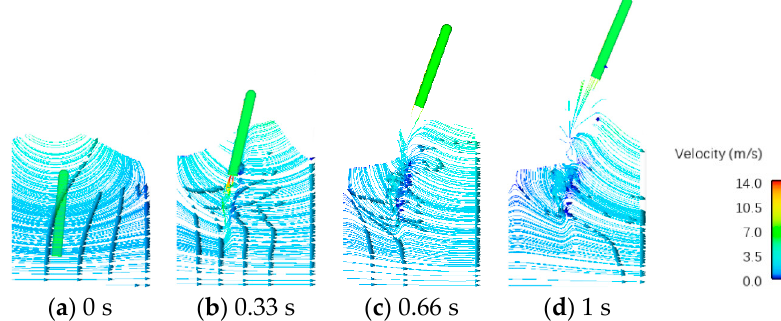
Figure 20. Streamline diagram of vehicles flying out of water in case 2.